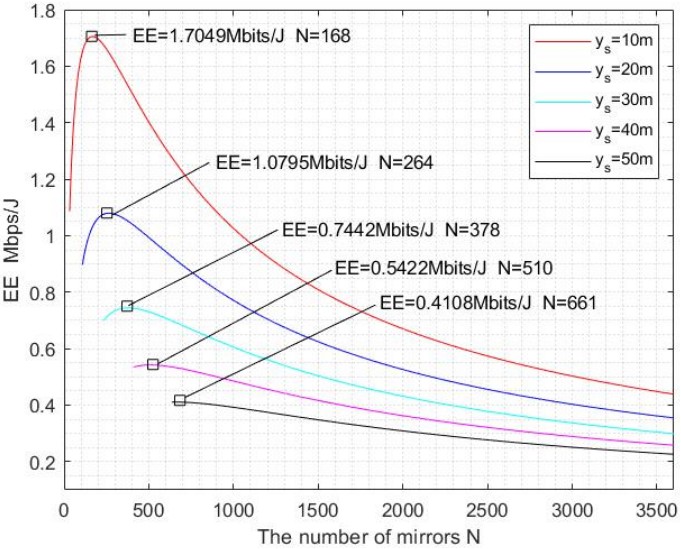
Figure 6. EE versus N with different y s .